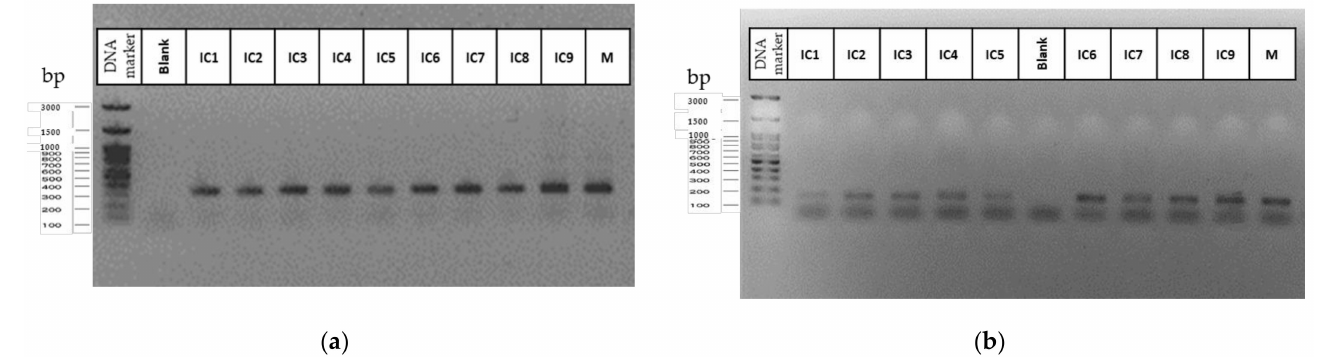
Figure 7. SSR amplification pattern obtained for the mother plant (M) and the in vitro cultured plants (I1–I9) for the SSR primers B01-CANN1 ( a ) and ANUCS 304 ( b ). The DNA marker is a 100 bp DNA ladder (100 bp–3000 bp) (FastGene 100 bp DNA Marker, Nippon Genetics Europe GmbH, Düren,